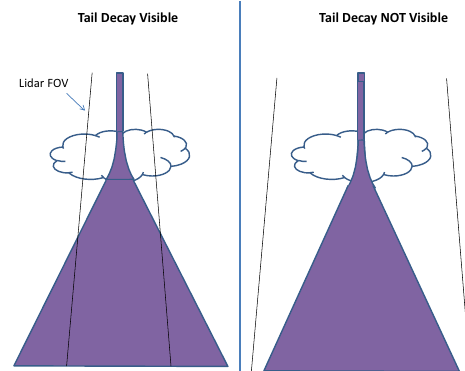
Figure 3: Schematic illustrating the basic mechanism behind the appearance of below cloud “tails” in space- based lidar